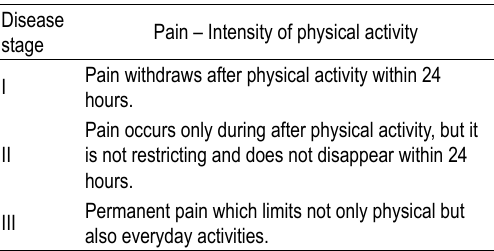
Table 1. Three stages of OSD - Criteria for